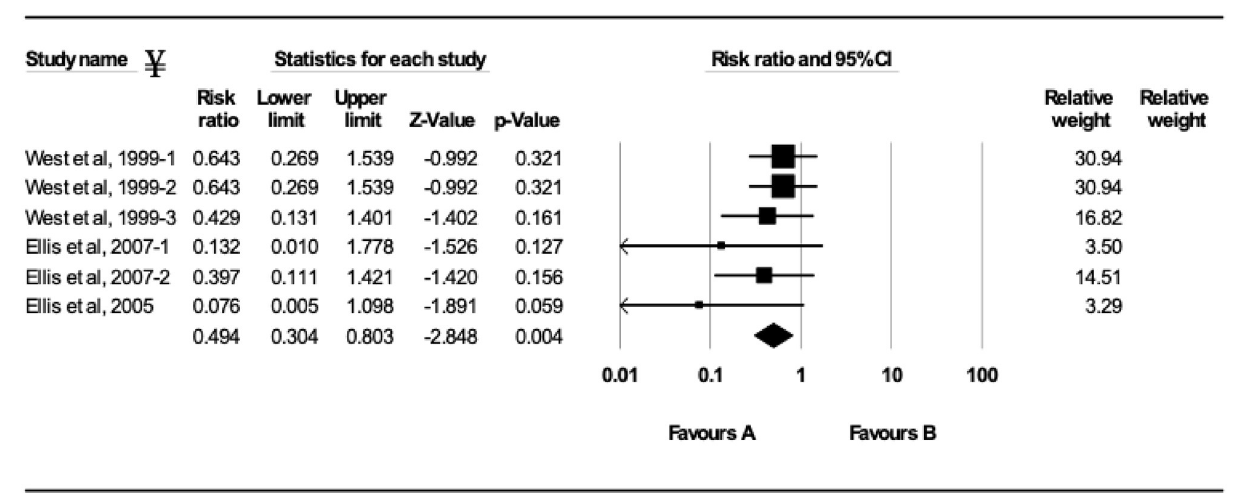
FIGURE 3 | Forest plot of morbidity risk ratios from experimental BRSV challenge trials that evaluated MLV and inactivated BRSV vaccines in seronegative calves (absence of maternal antibodies at initial vaccination). U Only trials with a significant morbidity effect between vaccinated and controls calves are shown by the meta-analysis software in the forest plot. Heterogeneity stats: Q -Value: 6.19, df ( Q ): 6 p : 0.40 I 2 : 3.21.